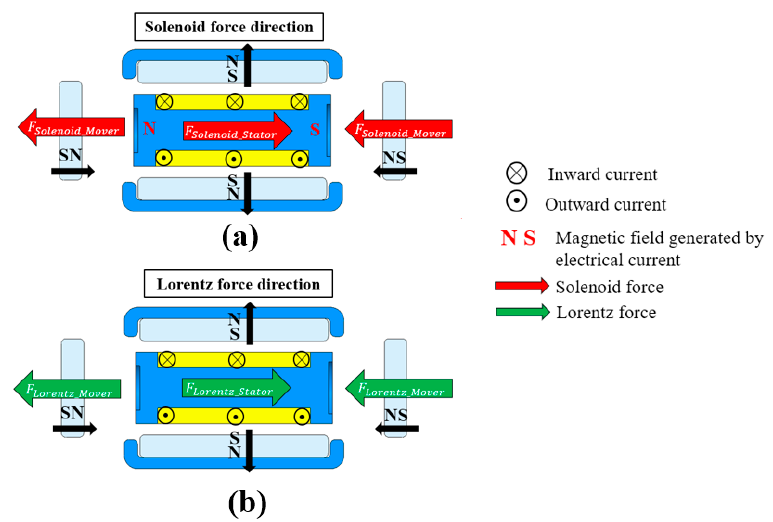
Figure 6. Current force directions: ( a ) solenoid and ( b ) Lorentz force direction.